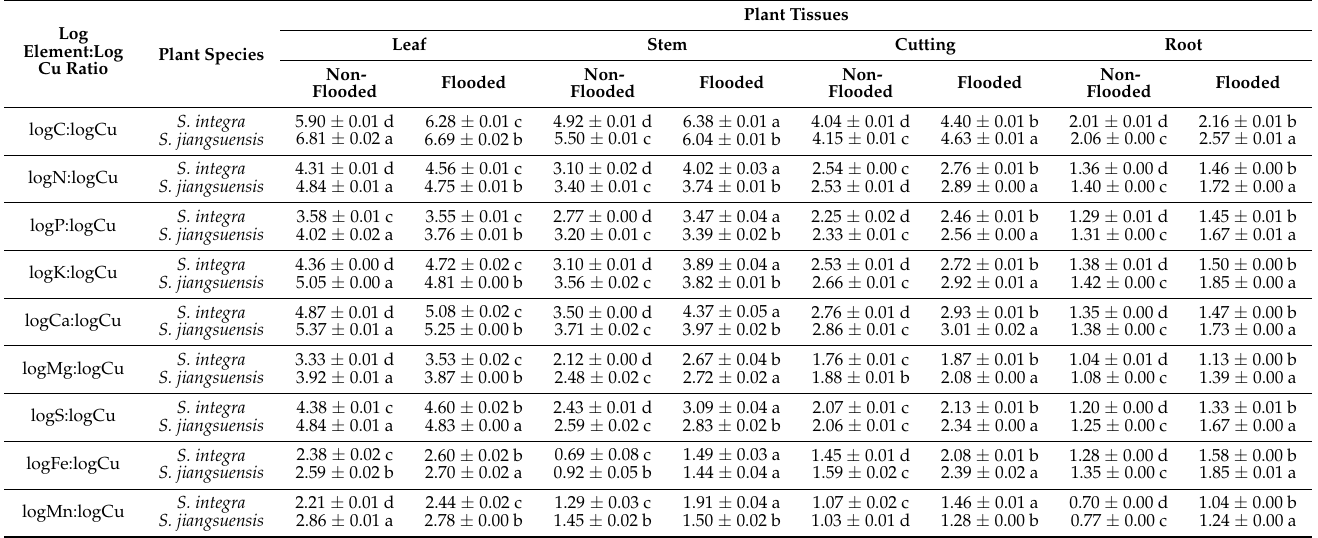
Table 5. Different element: Cu ratios of the two willows in response to non-flooded/flooded treatment with Cu